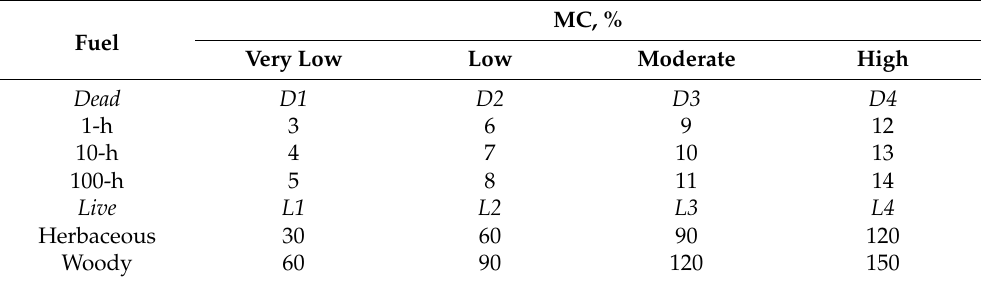
Table 2. Moisture scenarios according to Scott and Burgan [47].